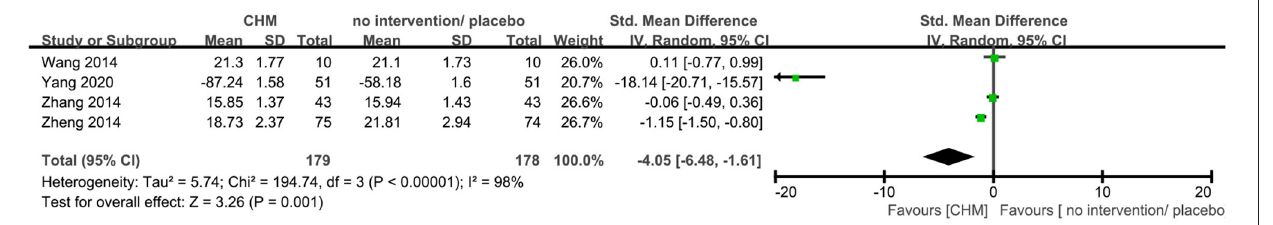
FIGURE 7 | Forest plot of comparison: CHM vs. no intervention/placebo, outcome: ADL.